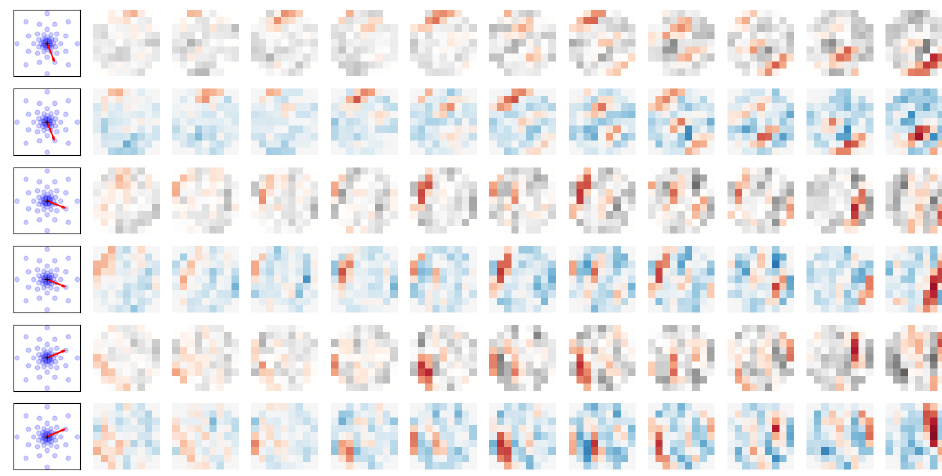
Figure 9. Detecting visual motion in an event stream with heterogeneous delays. Extending the polychrony detection model to the spatial domain, Grimaldi and Perrinet [196] have applied a supervised learning scheme to the detection of motion. The models’ parameters are represented by different spatio-temporal kernels, and we show three examples as pairs of rows, one targeting ON spikes, the other OFF spikes, the first column representing the corresponding motion detected. When trained on a set of natural images, it shows the emergence of localized, oriented kernels organized in a so-called push–pull organization for which weights to an ON spike are negatively proportional to that to an OFF cell [72]. Global weight is globally decreasing from the lowest delay ( right ) to less recent information ( left